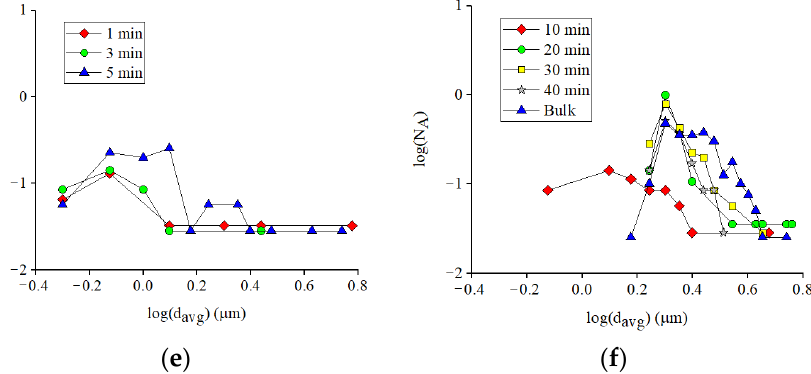
Figure 6. The particle size distribution of CaS type inclusions in ( a , b ) Exp. 2035, ( c , d ) Exp. 3035, and ( e , f ) Exp. 2025.